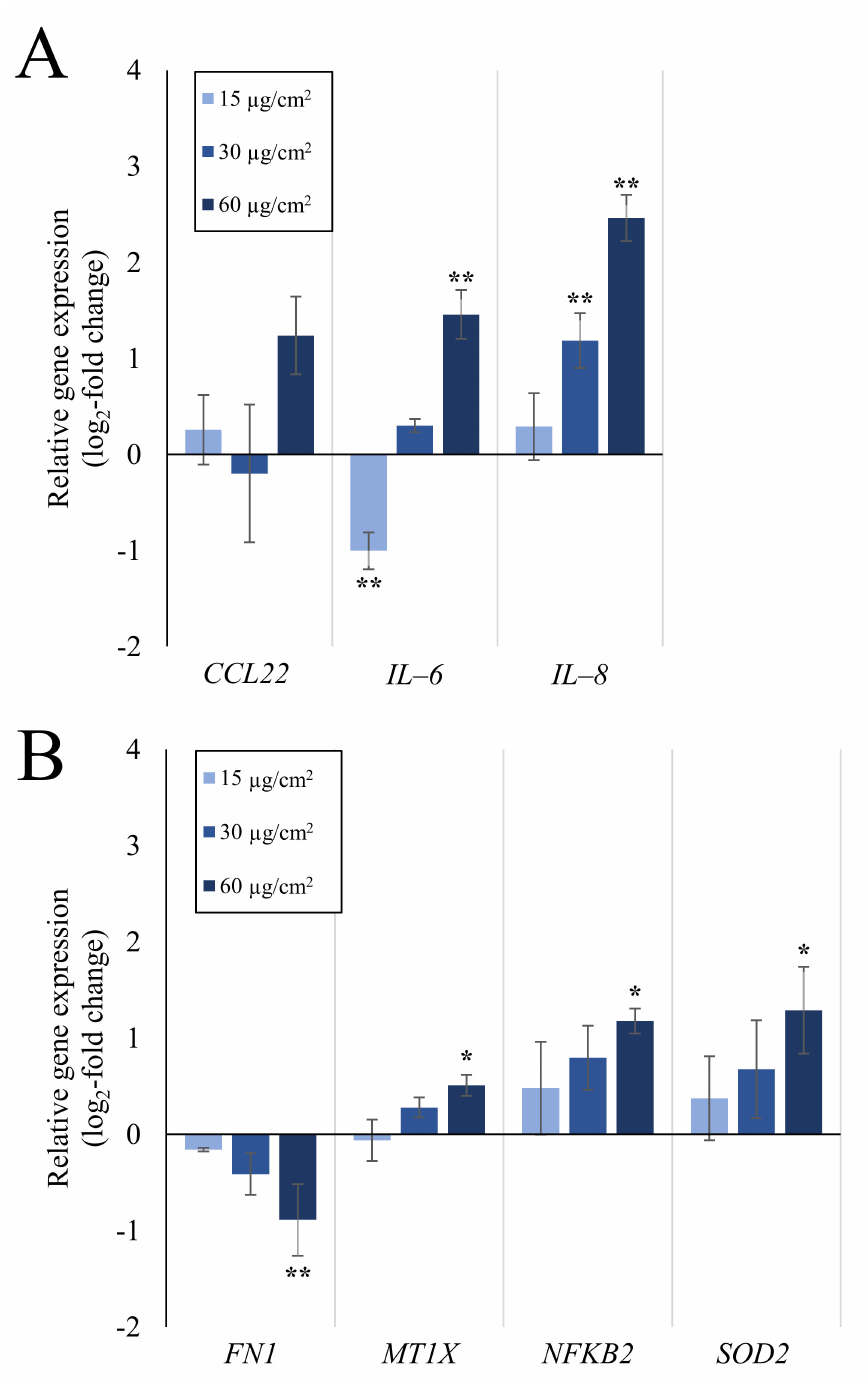
Figure 2. Impact of submerged Min-U-Sil5 exposure on the expression of inflammatory genes ( A ) and genes various gene clusters ( B ) significantly altered in their expression in A549 mono-cultures. A549 cells were exposed to three different doses of Min-U-Sil5 and incubated for 24 h. Results are depicted as the log 2 -fold change of the relative gene expression. The means ± SD of three independent experiments performed in duplicates are displayed. Statistical analysis was performed to assess differences between the exposed cells and the negative control with one-way ANOVA followed by Dunnett’s post hoc test: * ( p ≤ 0.05), ** ( p ≤